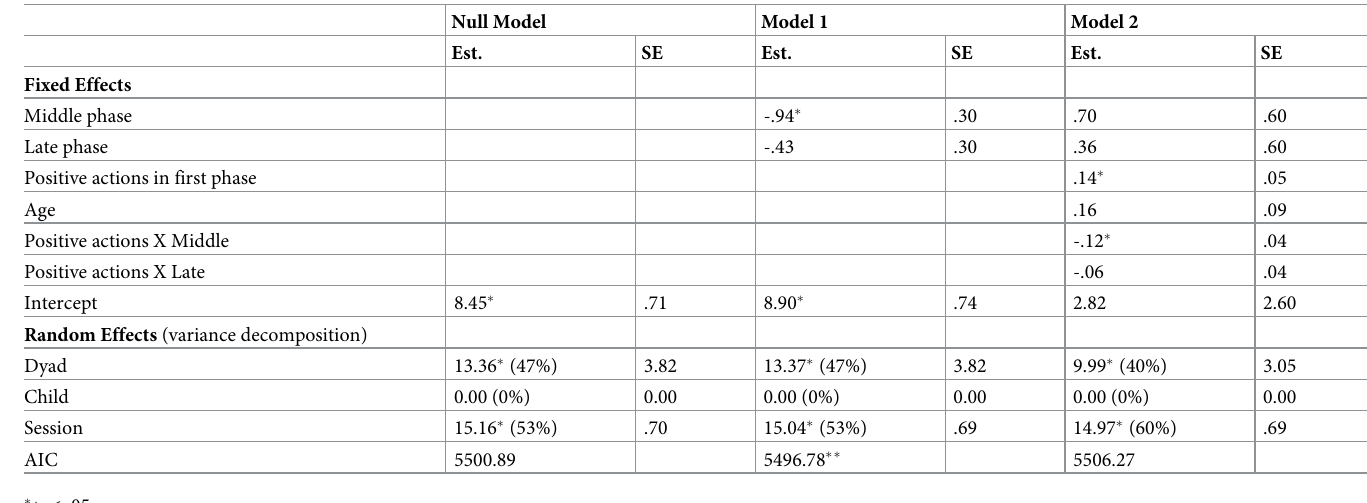
Table 4. Cross-classified multilevel model examining frequency of conflict sequences with phase, positive actions in the first phase, and age as